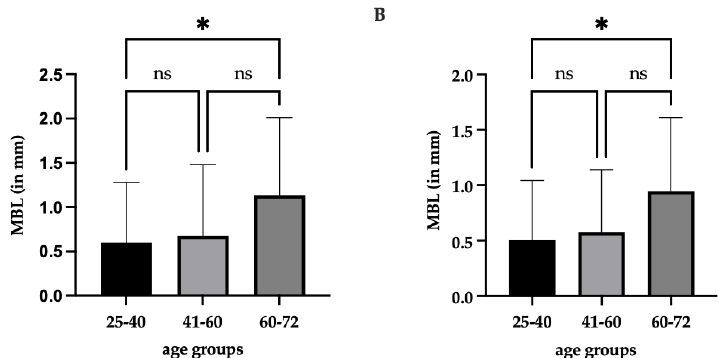
Figure 4. Marginal bone loss (MBL) in age groups. ( A ) all patients included in the study; ( B ) patients with peri-implantitis excluded. Error bars shown in this figure are means ± SD. The abbreviation ns is used for statistically nonsignificant, * statistically significant at p ≤ 0.05.